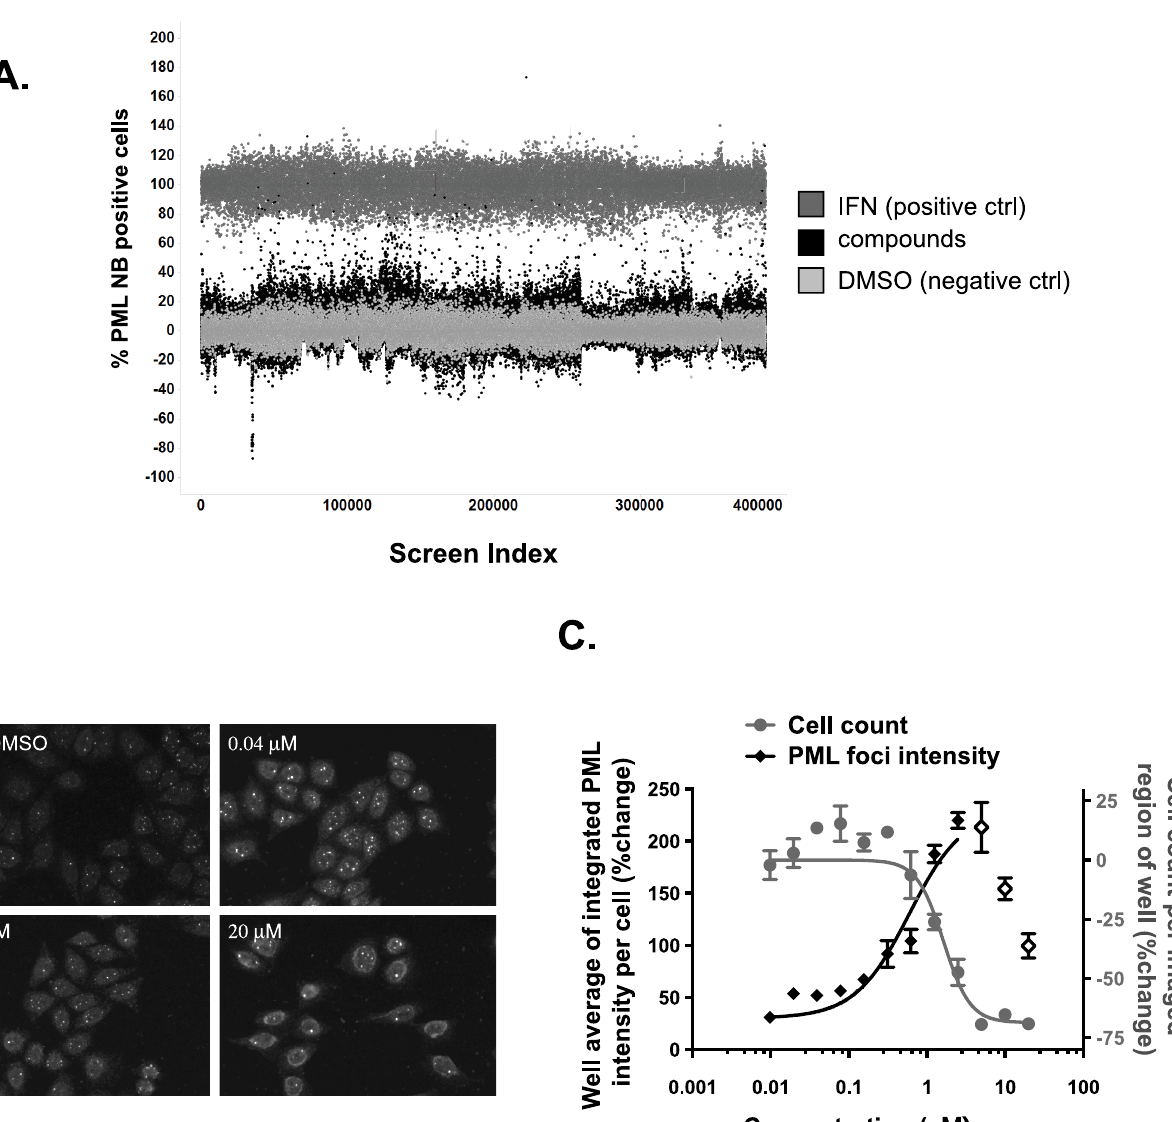
Fig 1. High content screening identifies cardiac glycoside as an inducer of PML nuclear body formation. A, Scatterplot of the data obtained from a total of 1,008 384-well library plates that were screened, imaged, and analyzed, yielding an average Z ’ of 0.50 and a hit rate of 0.3%. IFN 10 U/ μ l (positive control, dark gray), DMSO (negative control, light gray), compounds (black) B and C, HeLa cells were treated with increasing concentrations of gitoxigenin as well as DMSO as a negative control for 18h. PML NB formation was determined by immunofluorescence with anti-PML antibody and was analyzed using an algorithm described in Materials and Methods. The images are representative PML NB staining of cells treated with DMSO and 0.04 μ M, 1.25 μ M and 20 μ M gitoxigenin for 18h (B). The graphs show fitted curves for PML NB (black diamonds) and cell count (grey circles) over the full dose range of gitoxigenin (C). PML NB values at high concentrations are shown with open diamonds and are excluded from the fitted curve due to the cytotoxicity as evident from dramatic decrease in cell counts at these concentrations.